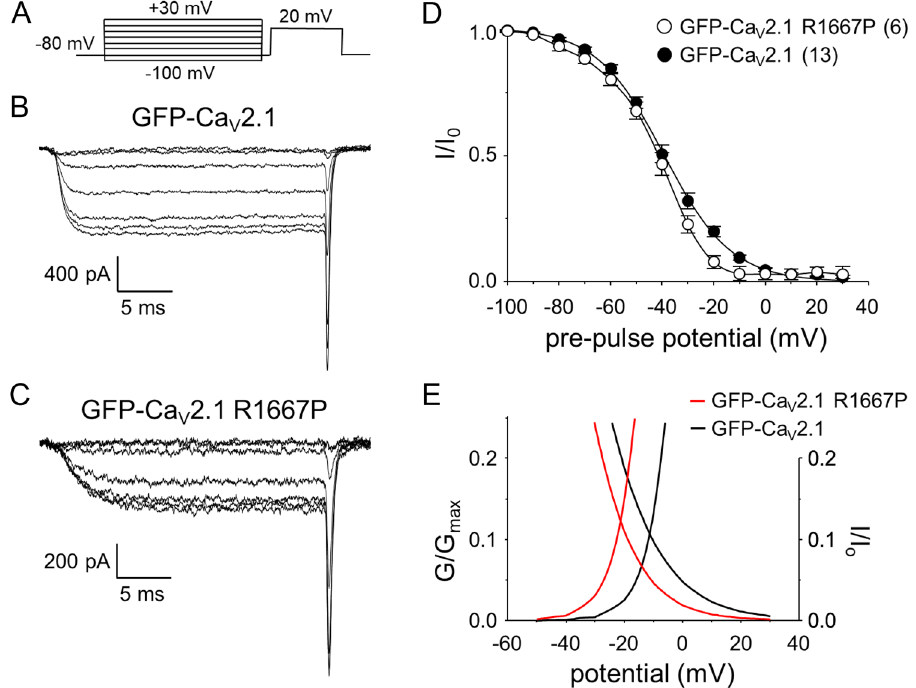
Figure 4. The R1667P mutation has little effect on closed-state inactivation. ( a ) A 5 s conditioning step from the steady holding potential (− 80 mV) to increasing potentials ranging from − 100 to + 30 mV (in 10 mV increments) was applied before repolarizing the membrane to − 80 mV for 5 ms. Test currents were then evoked by a 25 ms step depolarization to + 20 mV. The protocol is not drawn to scale. Representative Ca 2+ currents recorded from tsA-201 cells expressing GFP-Ca V 2.1 ( b ) or GFP-Ca V 2.1 R1667P ( c ) after pre-pulses to − 100, − 80, − 60, − 40, − 20, 0 and + 20 mV. Normalized steady-state inactivation curves for GFP-Ca V 2.1 (filled circle; n = 13) and GFP-Ca V 2.1 R1667P (open circle; n = 6) are shown in ( d ); amplitudes were normalized by the maximal Ca 2+ current in each cell. The normalized inactivation relationships were fit with Eq. (3) with the following fit parameters for GFP-Ca V 2.1 and GFP-Ca V 2.1 R1667P: V 1/2inact = − 39.3 ± 15 and − 42.1 ± 1.8 mV; k = − 12.6 ± 0.6 and − 10.7 ± 0.7 mV, respectively. ( e ) Overlay of the smooth conductance and closed-state inactivation curves (from Figs. 2c and 4d, respectively) for cells expressing GFP-Ca V 2.1 (black lines) and GFP- Ca V 2.1 R1667P (red